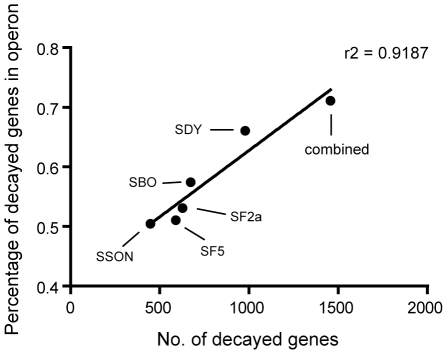
Correlation between number of decayed genes and percentage of decayed genes in operon.The dot “combined” represents all decayed genes in the five Shigella strains and the corresponding percentage of decayed genes in operon.